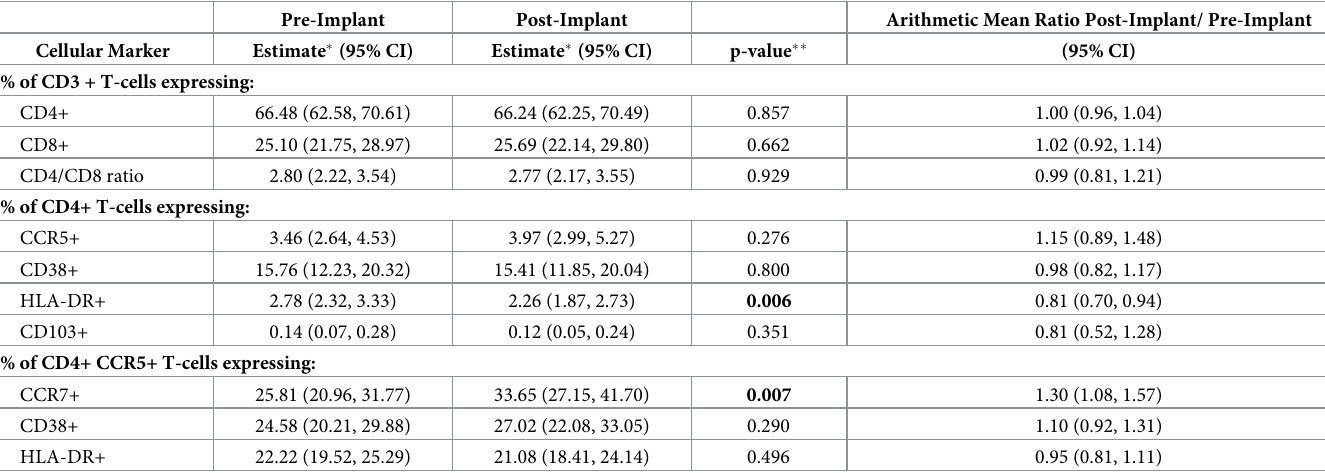
Table 4. Estimated cellular marker levels in PBMC for implant users, adjusting for repeated